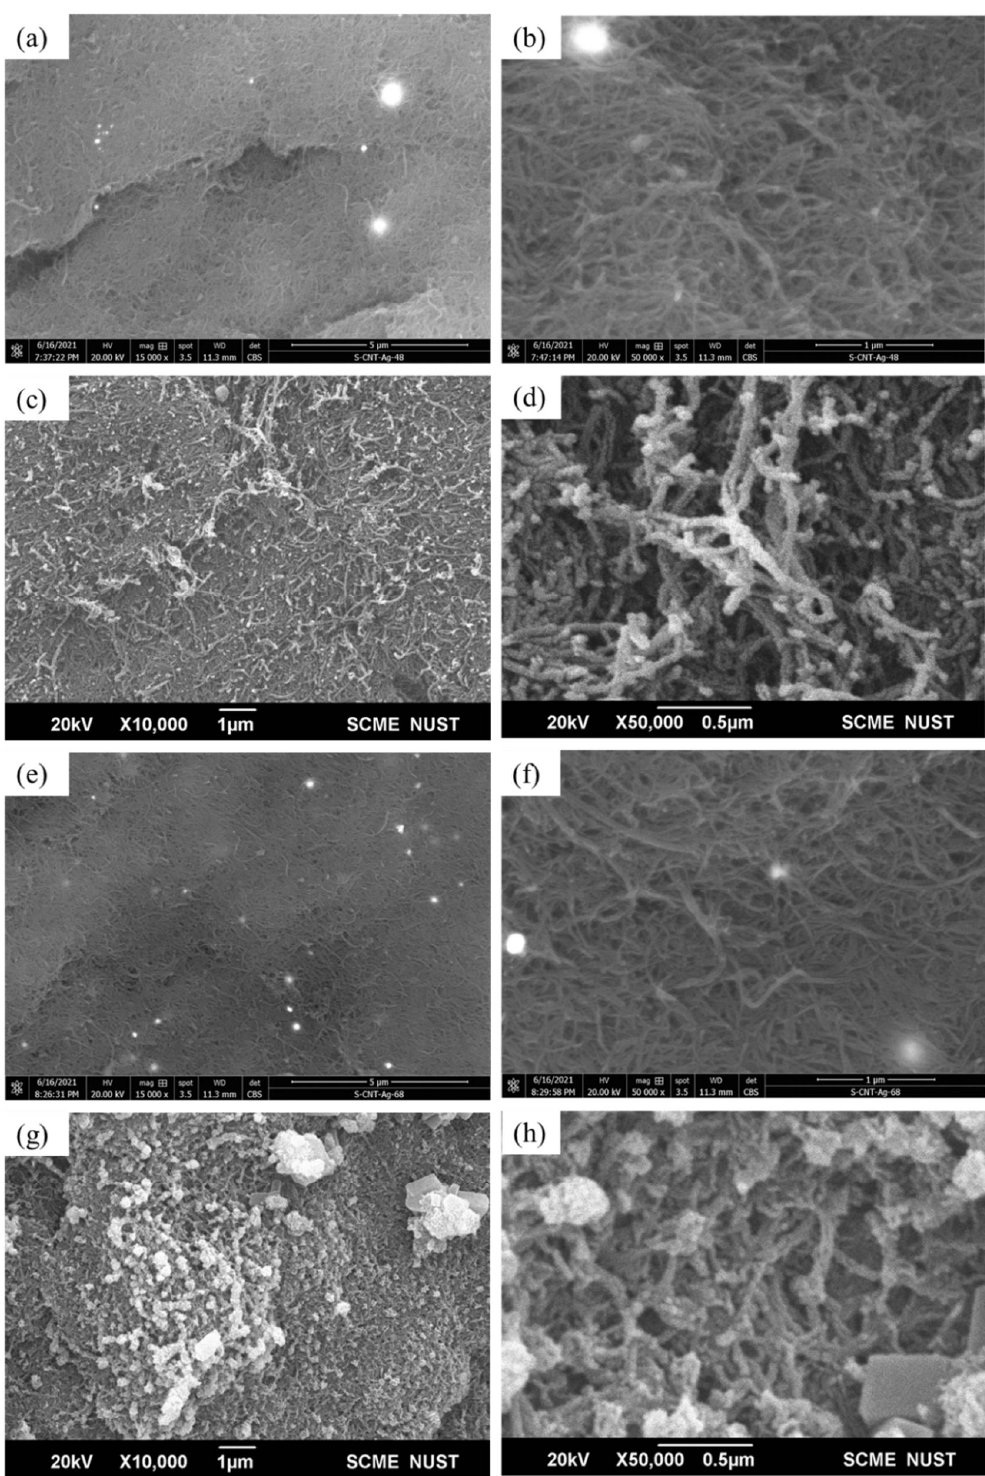
Figure 10. FESEM images of sintered membranes. ( a ) Low-magnification image of MWCNT-Ag membrane synthesized at 800 °C and 80 MPa; ( b ) high-magnification image of 800 °C and 80 MPa membrane; ( c ) image of membrane (900 °C and 80 MPa) at low magnification; ( d ) high-magnification image of 900 °C and 80 MPa membrane; ( e ) low-magnification image of membrane produced at 800 °C and 120 MPa; ( f ) high-magnification image of 800 °C and 120 MPa membrane; ( g ) Image of 900 °C and 120 MPa membrane at low magnification; ( h ) high-magnification image of membrane synthesized at 900 °C and 120 MPa.